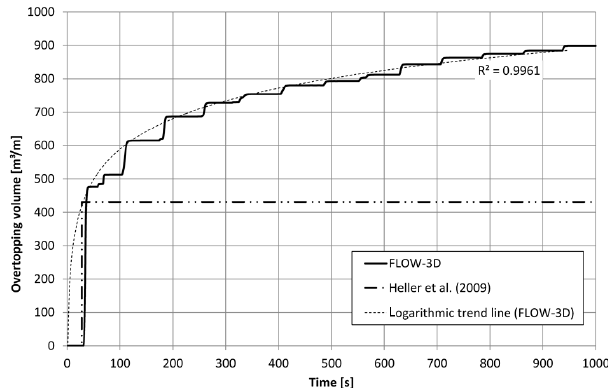
Figure 5. Accumulation of the overtopping volume V over the dam for the reference geometry including a logarithmic trendline for the approximation of the FLOW-3D